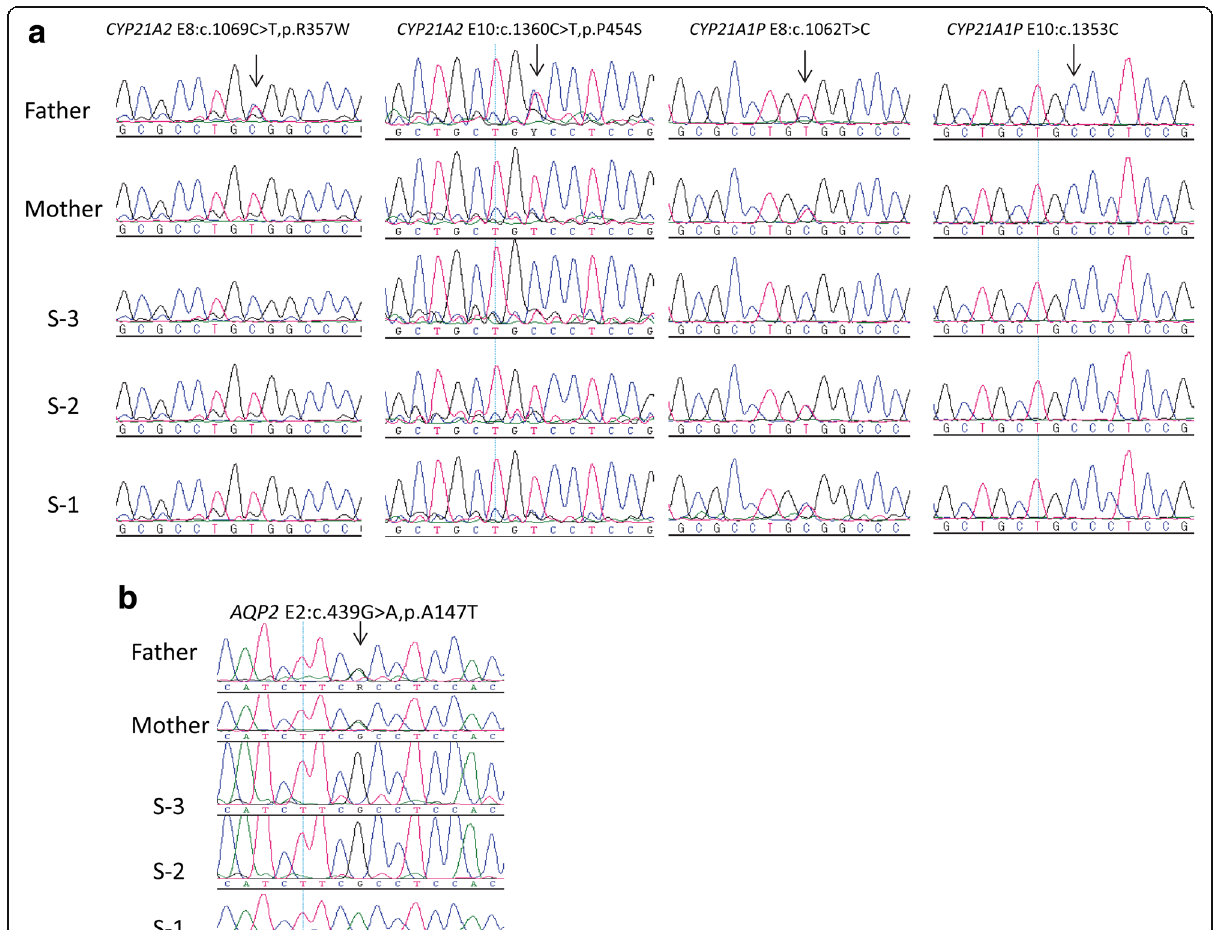
Fig. 1 Sequence analysis of CYP21A2, CYP21A1P and AQP2 in patient and family members. a Homozygous CYP21A2 c.1069C>T (p.R357W) in exon 8 and c.1360C>T (p.P454S) in exon 10 are present in patient (S-1), her unaffected mother and sister S-2. Father is a heterozygous carrier and sister S-3 is normal. Mutations and corresponding CYP21A1P pseudogene sequences are indicated by an arrow. A pseudogene-specific primer pair